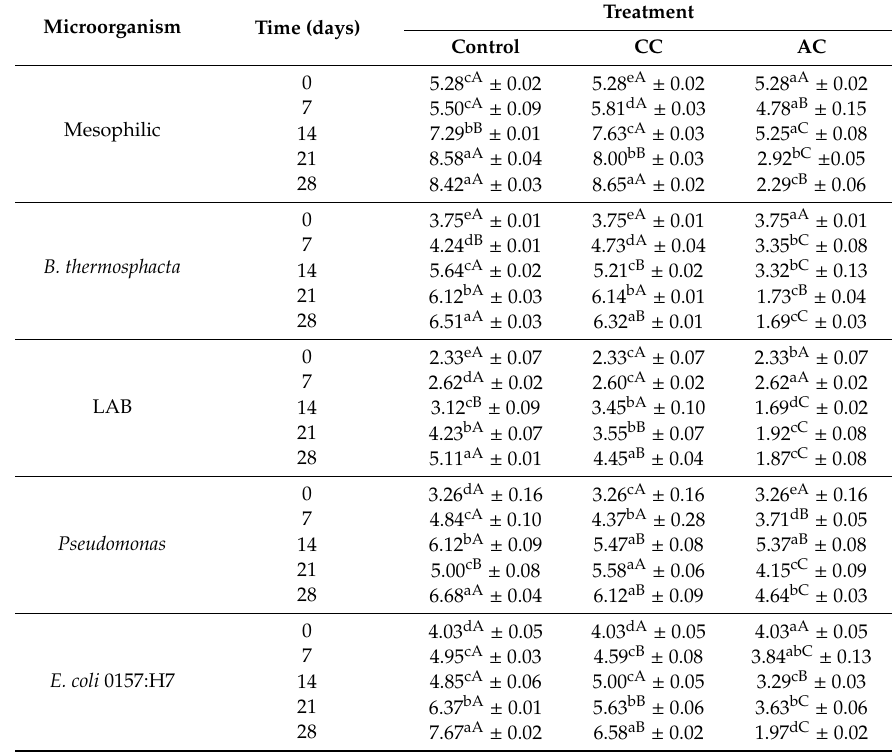
Table 3. Effect of active coating containing microencapsulated MOEO and BEO on total population, B. thermosphacta, LAB, Pseudomonas , and E. coli O157:H7 growth (Log CFU / cm 2 ) of fresh pork meat stored at 4 ◦